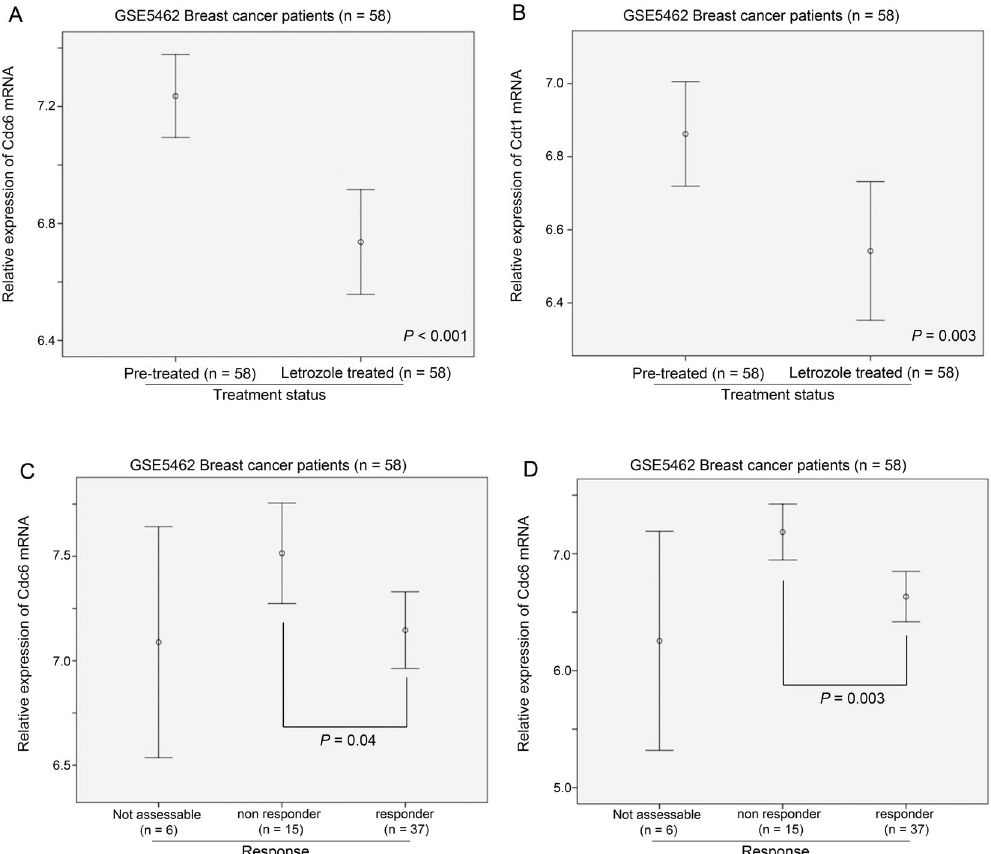
Figure 7. The expression of Cdc6 and Cdt1 in breast cancer specimens treated with letrozole. Error plots showing the expression levels of ( A ) Cdc6 and ( B ) Cdt1 in breast cancer specimens pre- and post-treatment with letrozole. Error plots showing the impact of ER signalling inhibition on the expression of Cdc6 in breast cancer specimens ( C ) pre-treatment and ( D ) post-treatment with